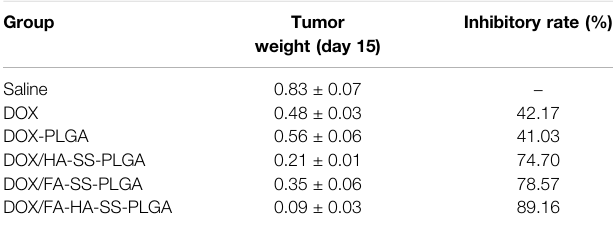
TABLE 3 | Inhibitory effects of different preparations on tumor weight and growth in tumor-bearing mice ( n = 5, (cid:1) x ± SEM). Group